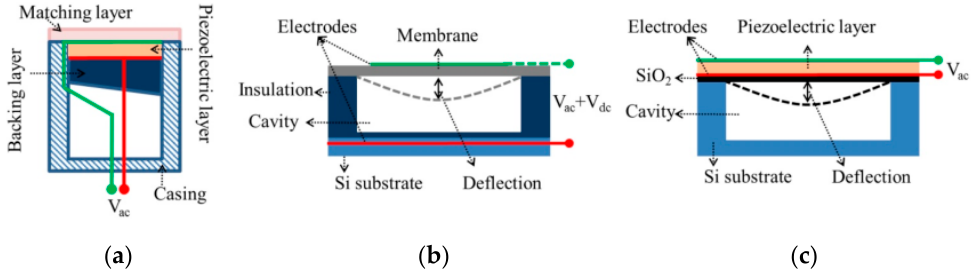
Figure 1. Typical cross-sectional structures of ( a ) piezoelectric ultrasonic transducers; ( b ) CMUTs and ( c ) d31-mode PMUTs [51].